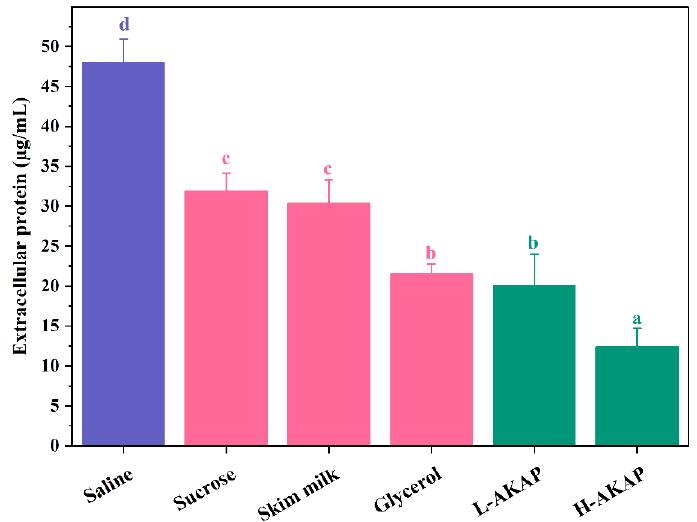
Figure 5. Effects of the negative control (saline), positive controls (1 mg/mL sucrose, 1 mg/mL skim milk, and 20% glycerol), 0.5 mg/mL antifreeze peptides from defatted Antarctic krill (AKAPs) (L-AKAP), and 1 mg/mL AKAP (H-AKAP) on concentrations of extracellular protein of L. rhamnosus after freezing. Bars with different lowercase letters (a, b, c, and d) indicate significant differences ( p < 0.05).